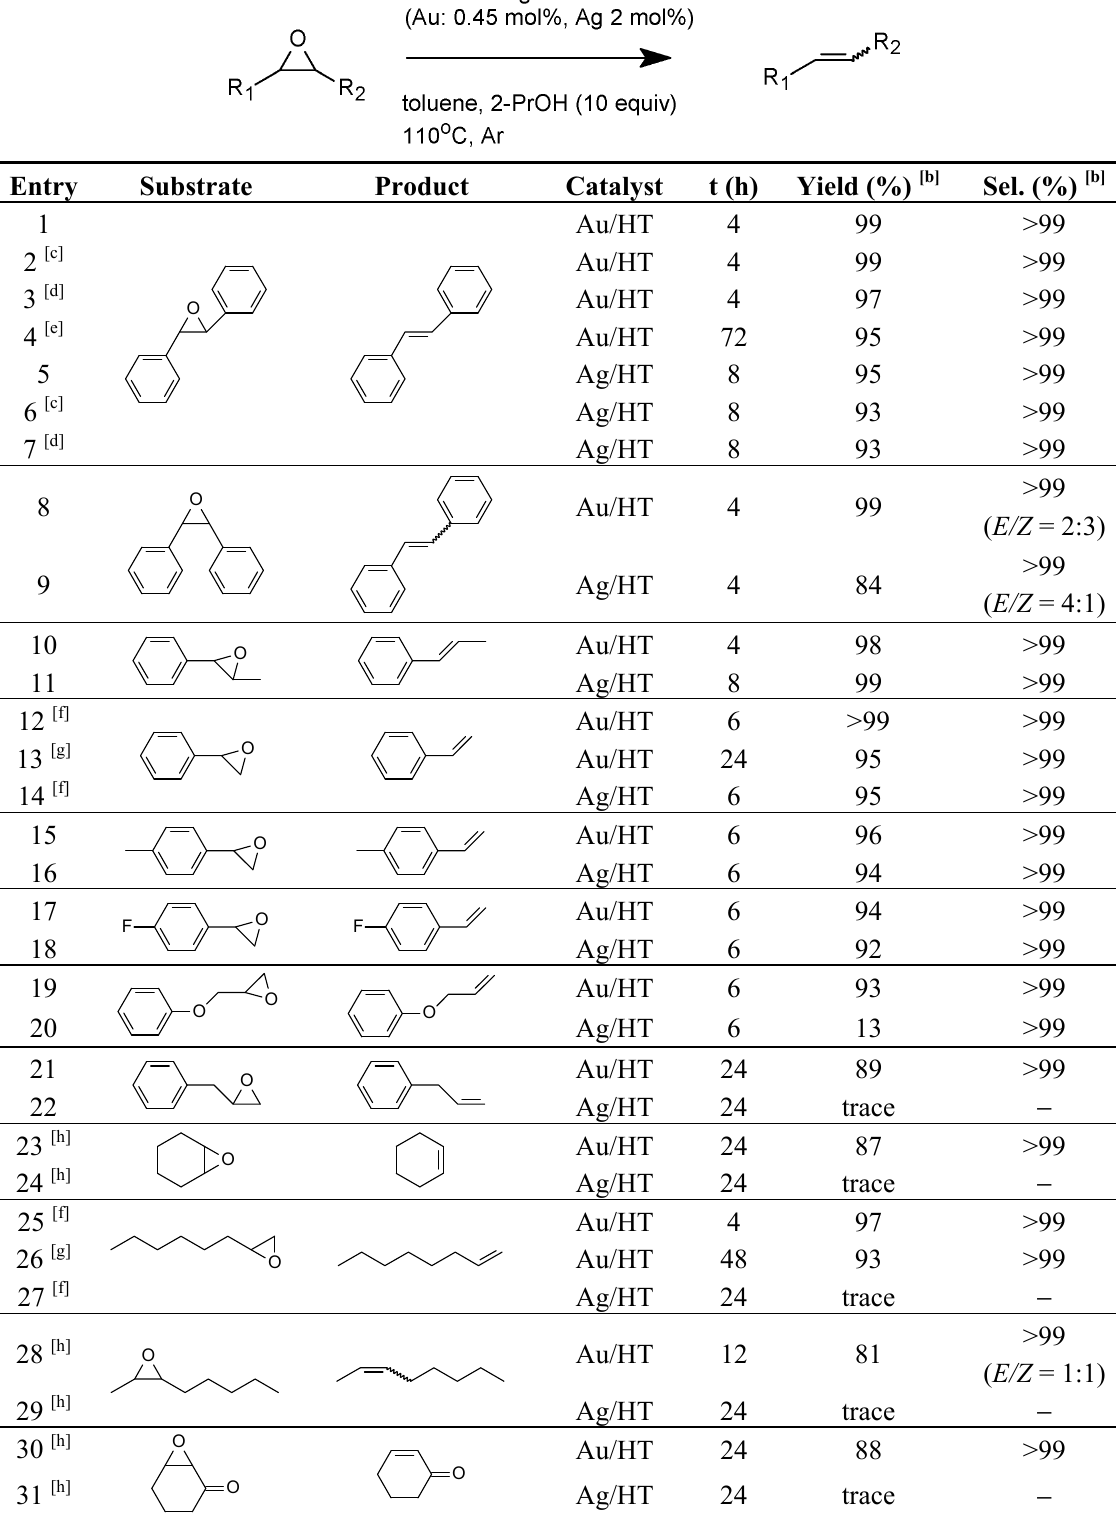
Table 1. Deoxygenation reactions of various epoxides over Au/HT (or Ag/HT) catalyst [a] . Reproduced with permission from Reference [43]. Copyright (2010) Wiley-VCH Verlag GmbH & Co.